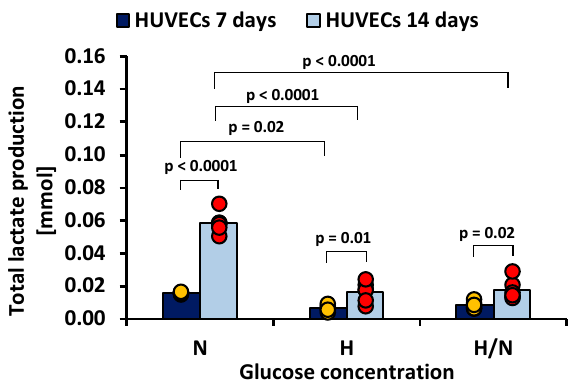
Figure 6. Lactate production by HUVECs after 7 and 14 days of culturing in medium with normal (N), high (H), or variable (H/N) glucose concentration on PSU flat membranes covered with fibronectin. The data are presented as scatter plot (yellow, green, red and blue dots) with corresponding bar graphs.